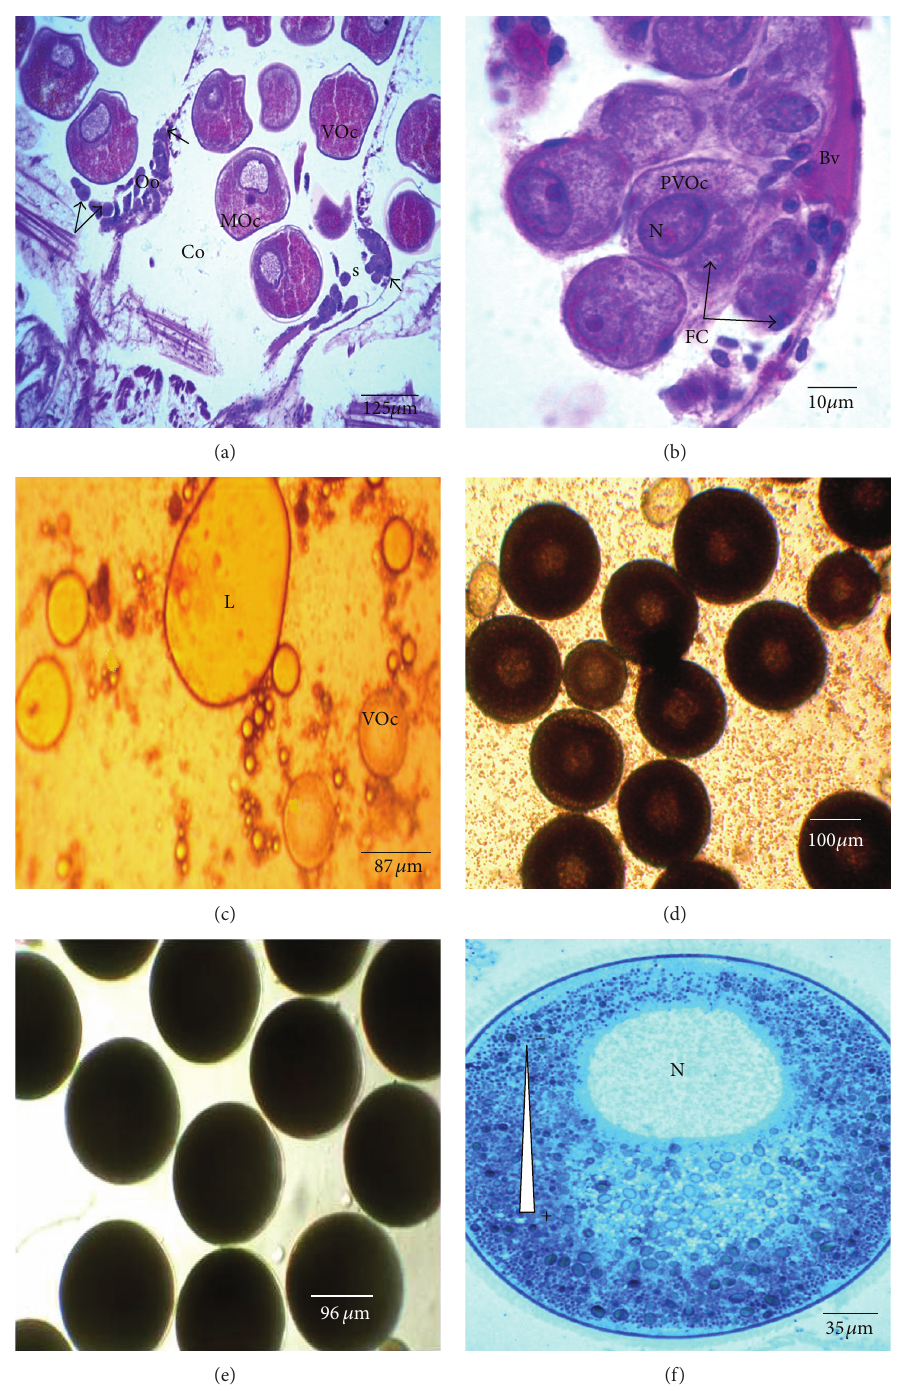
Figure 4: Ovogenesis. (a) Histological section of a posterior segment of a female collected in March showing ovaries (arrowheads) containing primary oocytes (arrows), oogonia (Oo), free vitellogenic (VOc) and mature oocytes (MOc) in the coelom (Co). (b) Detail of an ovary from an individual collected in May. The ovary consists of a germ-cell cluster surrounded by a thin envelope of follicle cells (FC) (arrows) and is attached to a blood vessel (Bv). (c) Coelomic fluid (Co) from a female collected in August showing early vitellogenic oocytes (VOc) and numerous lipid droplets (L). (d) Coelomic fluid from a female collected in September showing vitellogenic oocytes. (e) Coelomic fluid from a female collected in December showing mature oocytes. (f) Detail of a mature oocyte from a female collected in January. The arrow indicates the gradient of distribution of the vitellus. N: nucleus; PVOc: previtellogenic oocyte; S: germinal